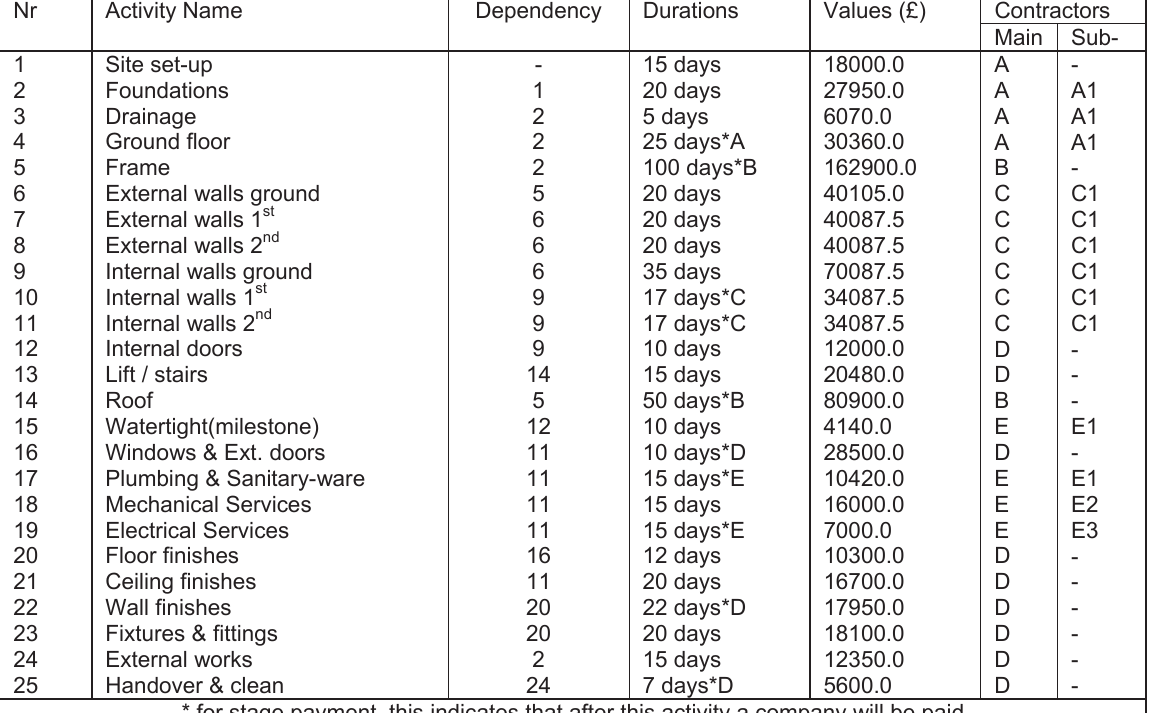
Table 1: Data of the Example